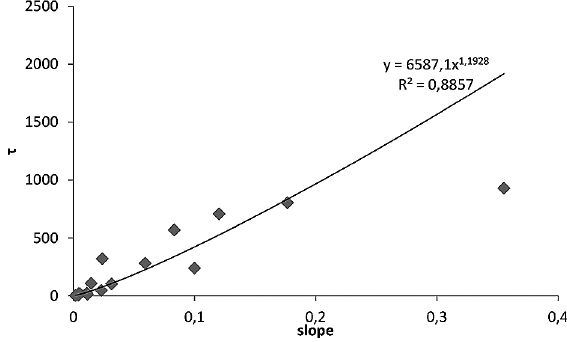
Fig. 5. Relation between Shear stress and slope.